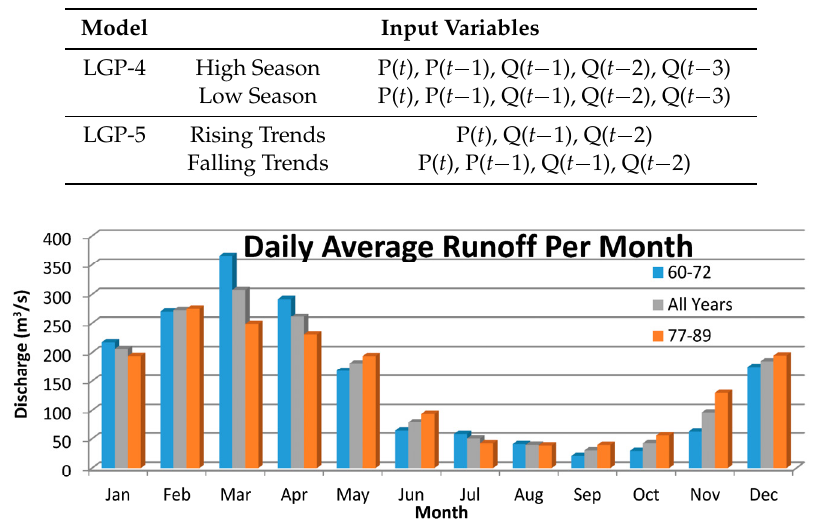
Figure 5. Each month’s average daily average discharge.